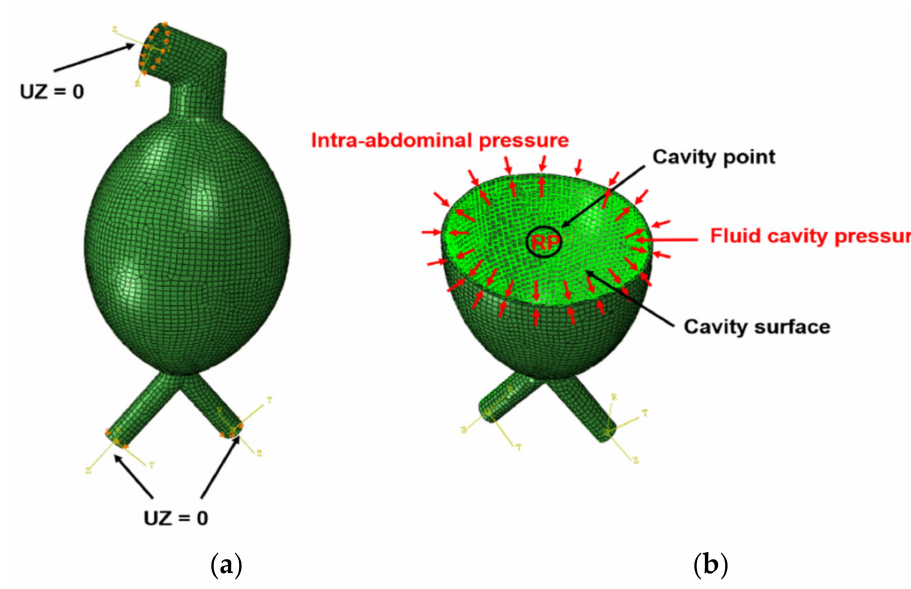
Figure 4. ( a ) Boundary condition and ( b ) loading condition in the used fluid